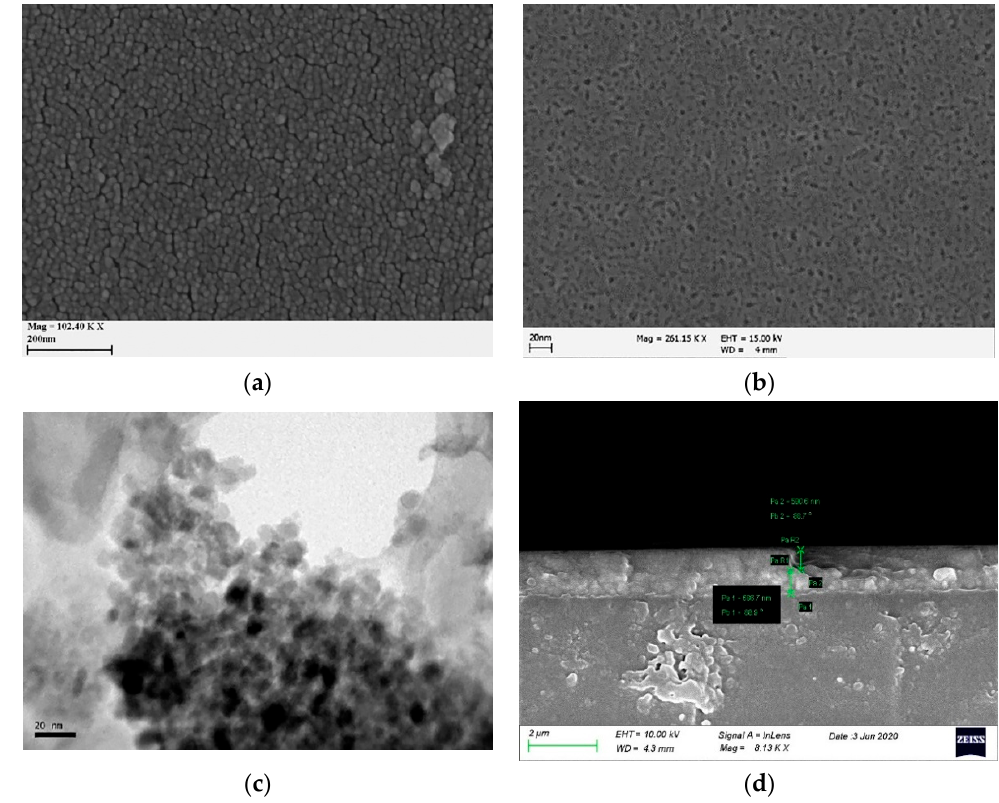
Figure 3. Top-view of ( a ) TiO 2 , ( b ) Ce- modified TiO 2 film, ( c ) TEM image of particles scratched from a Ce- modified TiO 2 film and ( d ) cross section view of a Ce- modified TiO 2 film (from [55] with copyright permission from Elsevier).